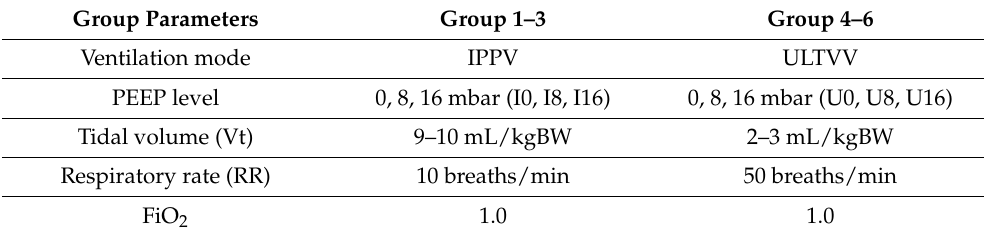
Table 1. Group design and intervention parameters during